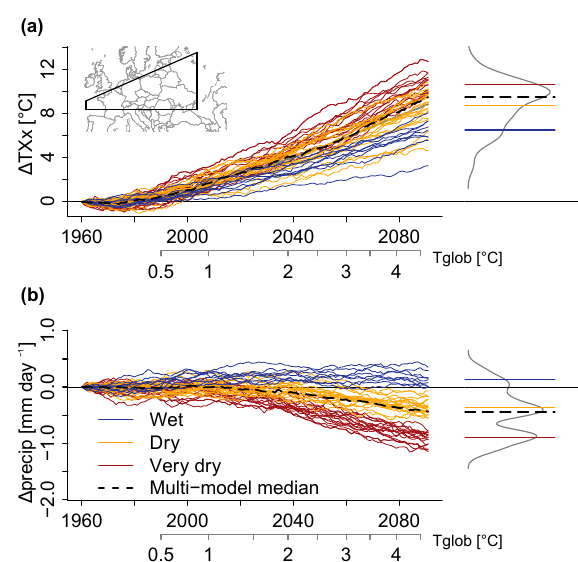
Figure 1. Change in (a) TXx and (b) summer precipitation (pre- cip) in Central Europe (CEU, defined in the inset of panel a ) for 44 model realizations for wet (blue), dry (orange), and very dry (dark red) models and the multi-model median (dashed). Changes are calculated as 20-year running means with respect to the base pe- riod 1950–1969. Density distributions are shown for changes in the 2081–2100 period with respect to the base period (right). The hor- izontal lines in the density distributions indicate the multi-model median of the wet (blue), dry (orange), and very dry (dark red) en- sembles and the multi-model median (dashed) for changes in the 2081–2100